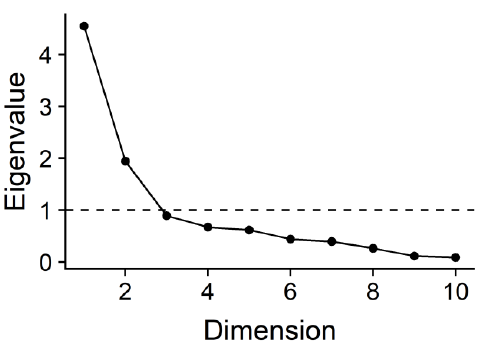
Figure A1. A scree plot of the survey data used to determine the optimal number of factors to use in the exploratory factor analysis. The two factors above the inflection point of the curve were retained.